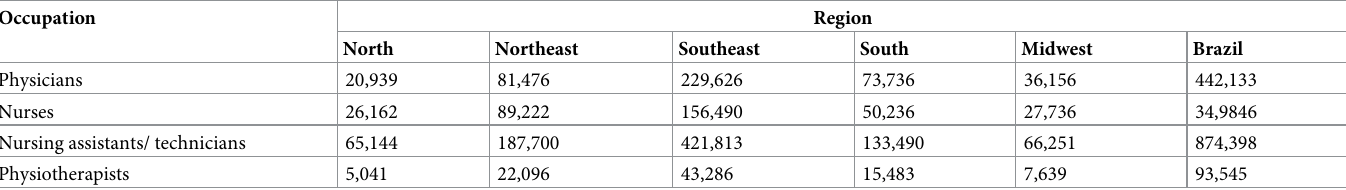
Table 1. Absolute frequency of some health professionals in each region in Brazil.